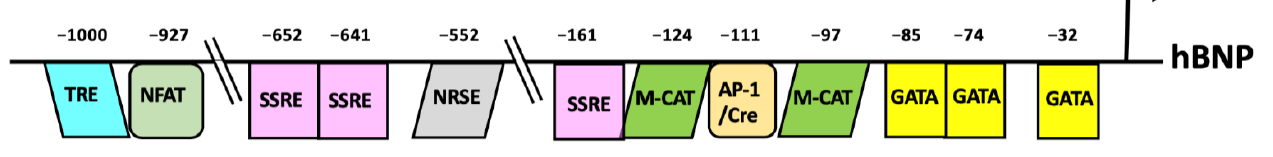
Figure 3. Schematic representation of the human BNP promoters showing the cis-acting elements identified so far.